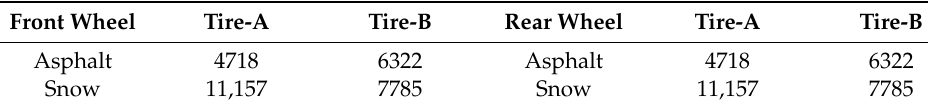
Table 1. Total number of generated images for each test case.